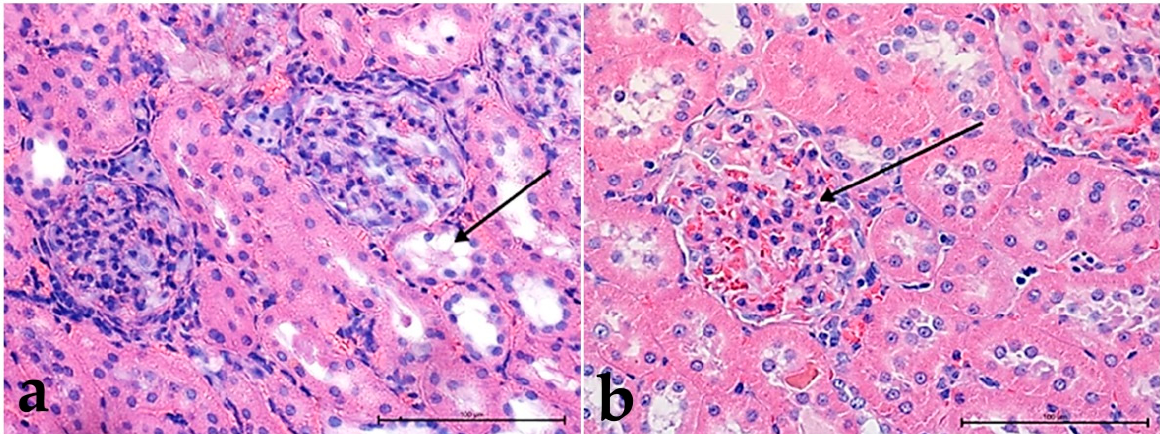
Figure 1. The structure of the kidneys in the control groups: in normal, I ( a ) and high-cholesterol diet, II ( b ); ( a ) note the lack of the urine in proximal tubules and slightly enlarged distal tubules (black arrow); ( b ) glomerulus filled with blood (black arrow) hematoxylin and eosin (H&E) staining. Mag. 400×. Bar scale 100 µm.